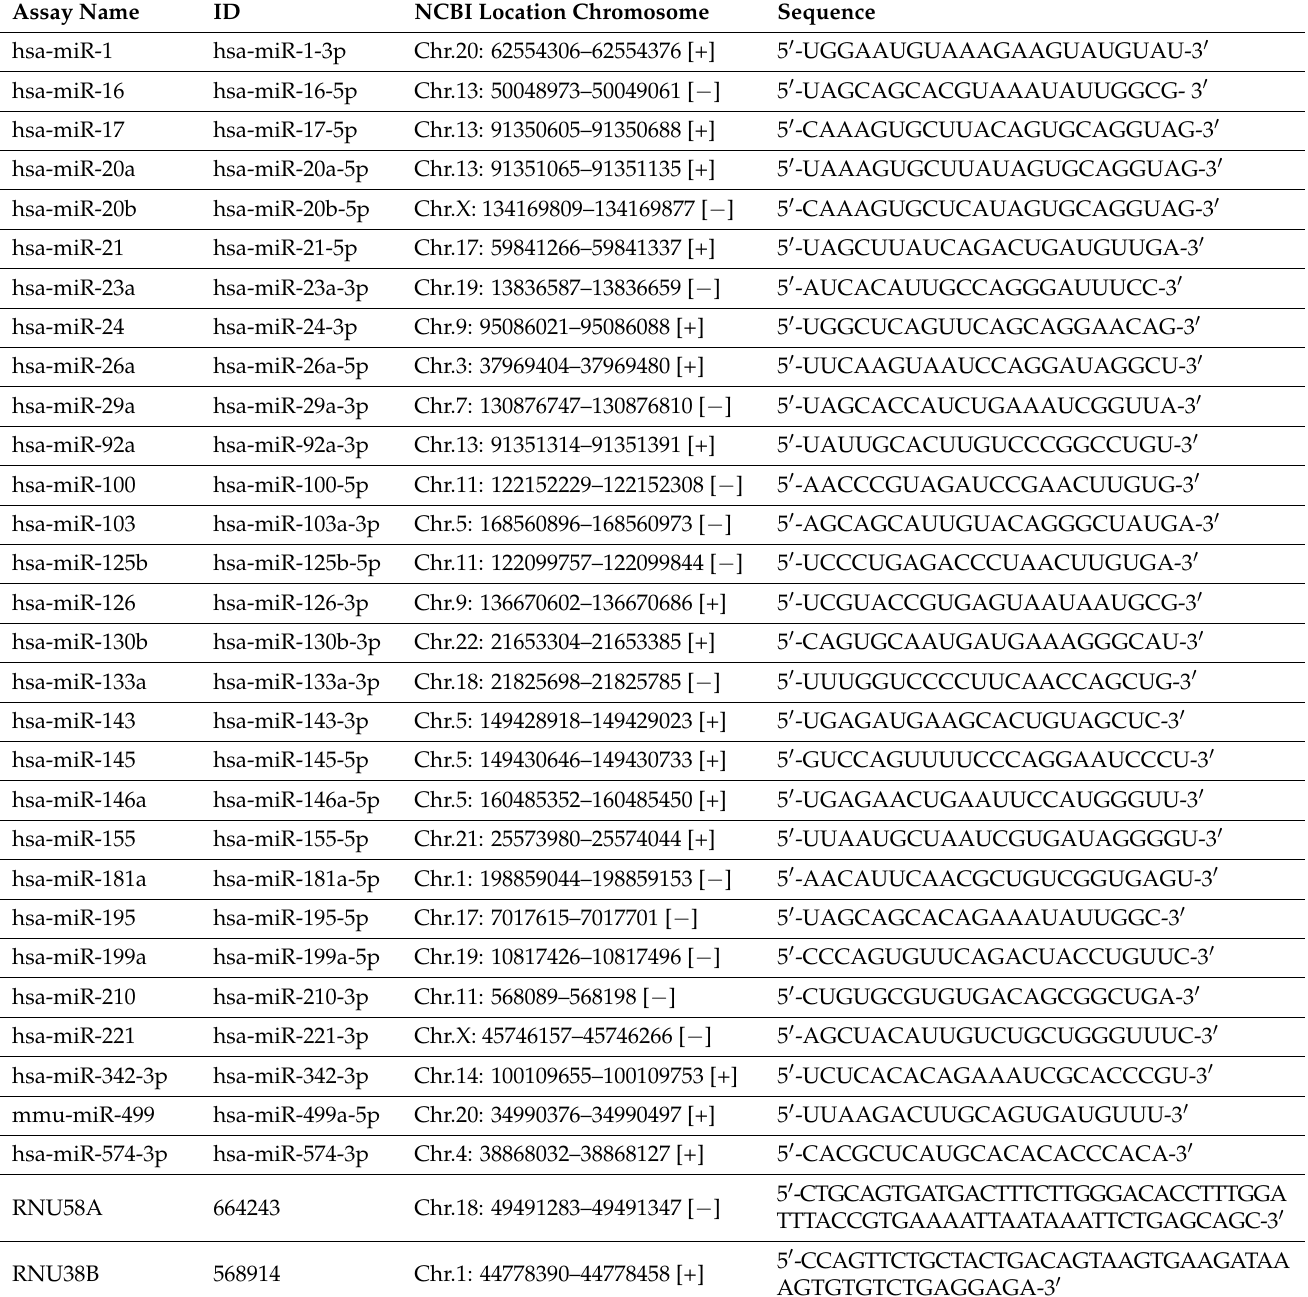
Table 5. Characteristics of microRNAs involved in the